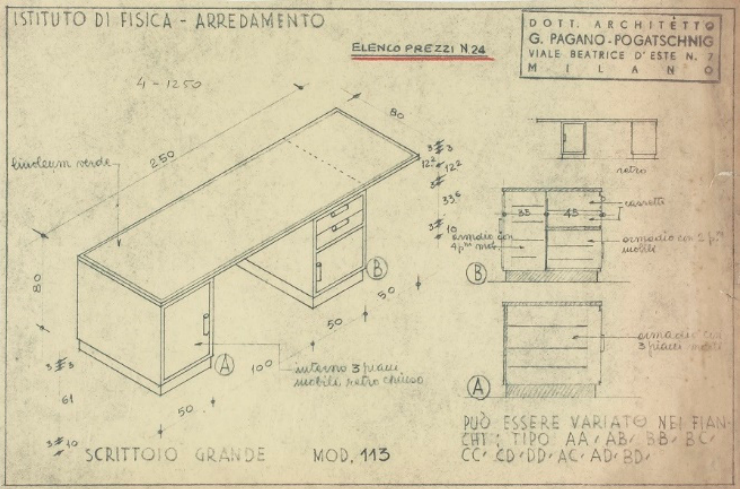
Figure 40. The laboratories with the furniture designed by Pagano. Photo from (De Smaele 1936, p. 25).